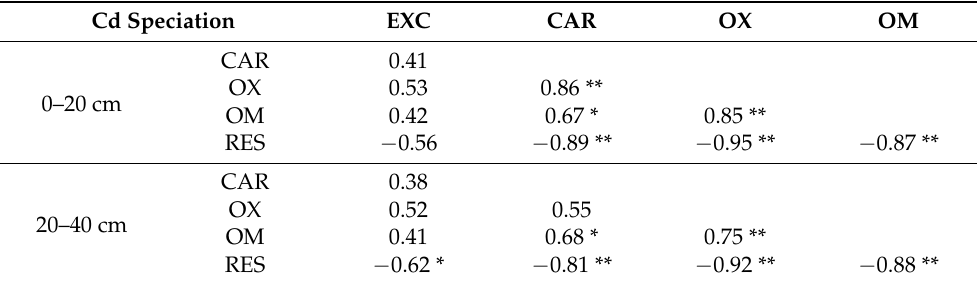
Table 5. Transformation of heavy metal Cd forms in surface soil during rice-rape rotation.